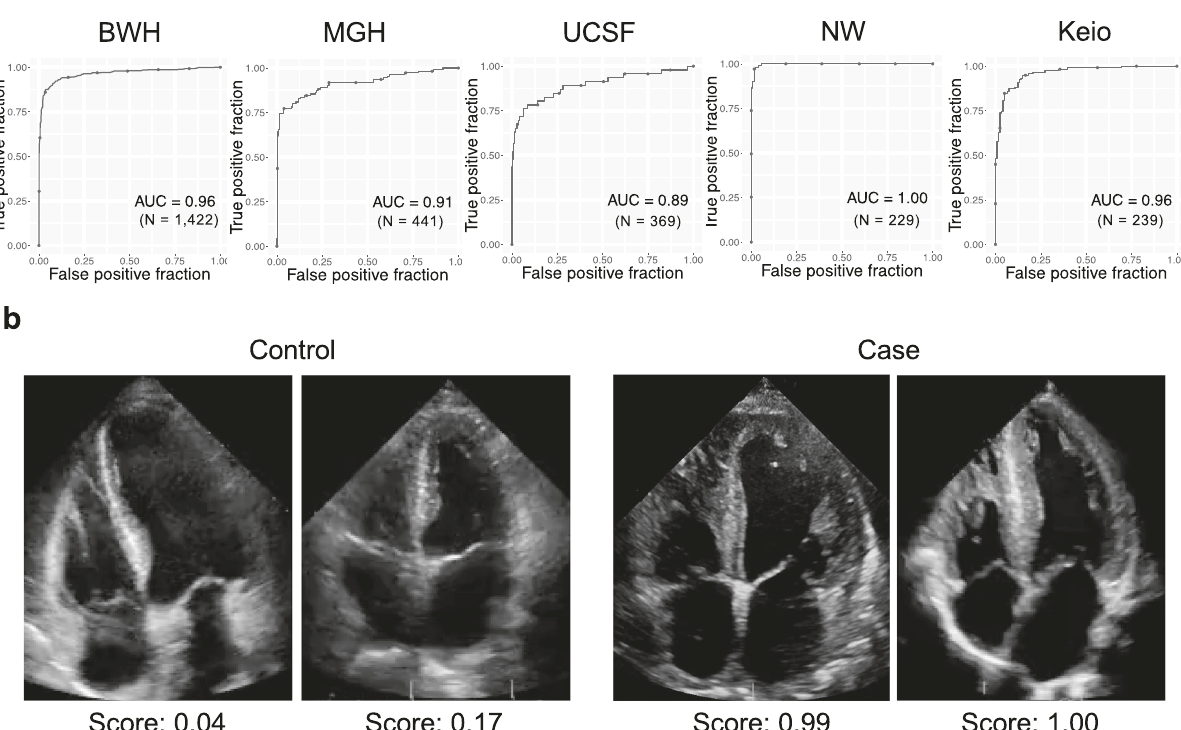
Fig. 2 Performance of the cardiac amyloidosis echocardiography model. a ROC plots for detecting cardiac amyloidosis for each institution. The performance on the test dataset is shown for BWH. b representative echocardiography images for cases and controls. The score denotes the model output for the video. N is the numbers of studies. Source data are provided as a Source Data fi le. BWH: Brigham and Women ’ s Hospital, MGH: